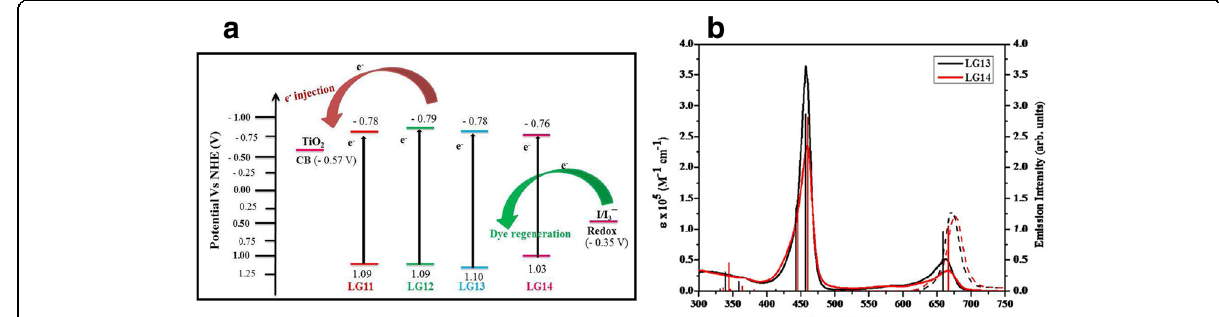
Fig. 20 Energy level diagram of LG-11 to LG-14 porphyrins, electrolyte and TiO 2 ( a ) and absorption (left, solid line) and emission (right, dashed line) spectra of porphyrin sensitizers LG-13 and LG-14 in the THF solvent ( b